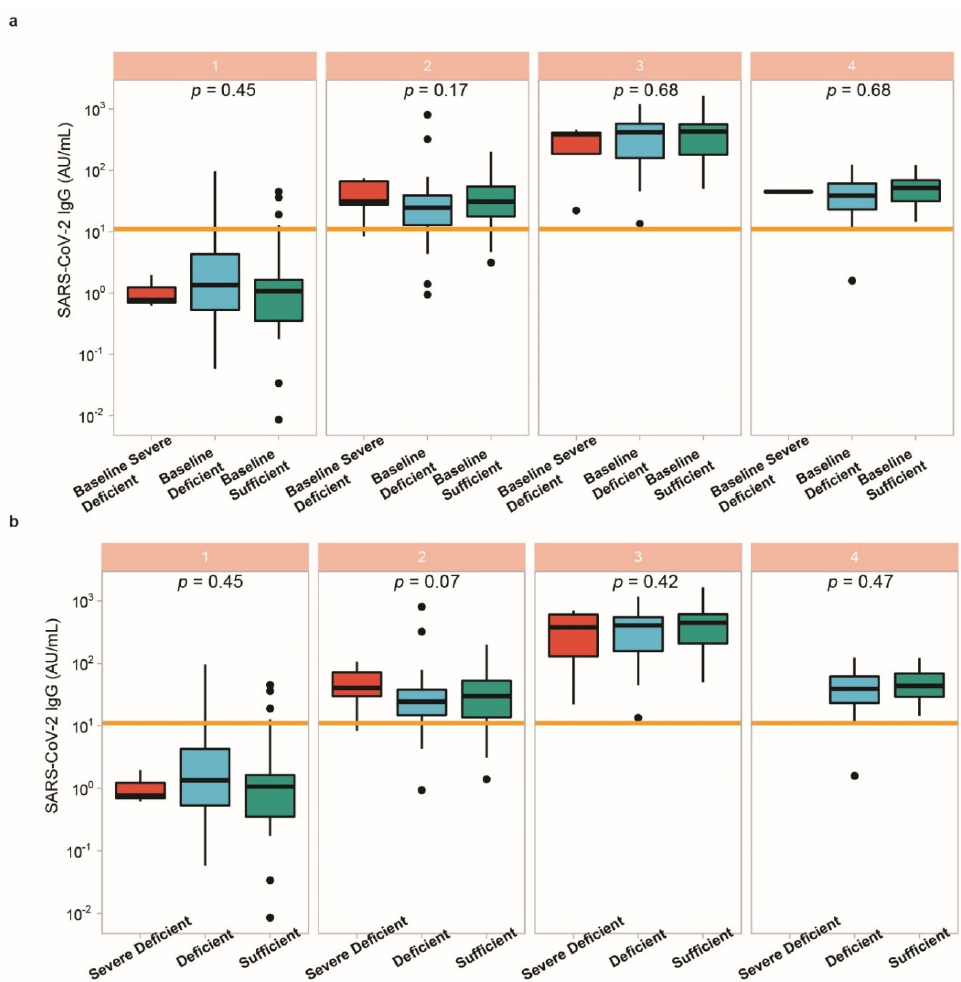
Figure A1. Sensitivity analyses including alternative cut offs for vitamin D status. Serum samples with vitamin D concentrations below 10 ng/mL were considered severely deficient, and below 30 ng/mL as deficient. ( a ) Baseline vitamin D status was compared to IgG levels over time, without detecting significant differences. ( b ) Vitamin D status was re-evaluated at each time point of sampling in relation to SARS-CoV-2 IgG titres over time, and the comparison did not reveal significant differences in antibody response in relation to 25(OH)D. Kruskal-Wallis test was used for comparing the groups.